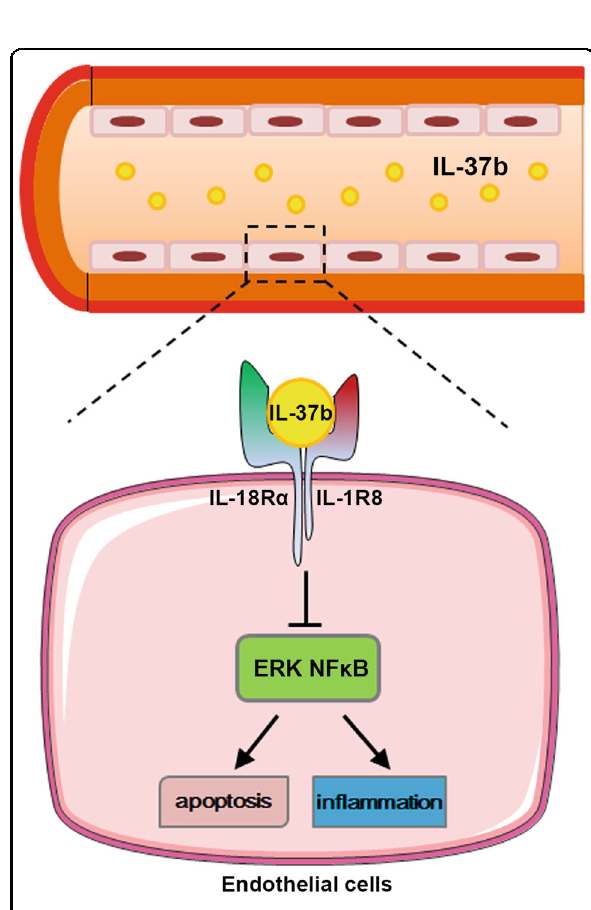
Fig. 8 Schematic model for IL-37b against endothelial cell damage in Kawasaki disease. IL-37b binds to IL-18 α and IL-1R8, inhibits ERK and NF κ B activation, and fi nally suppresses EC apoptosis and in fl